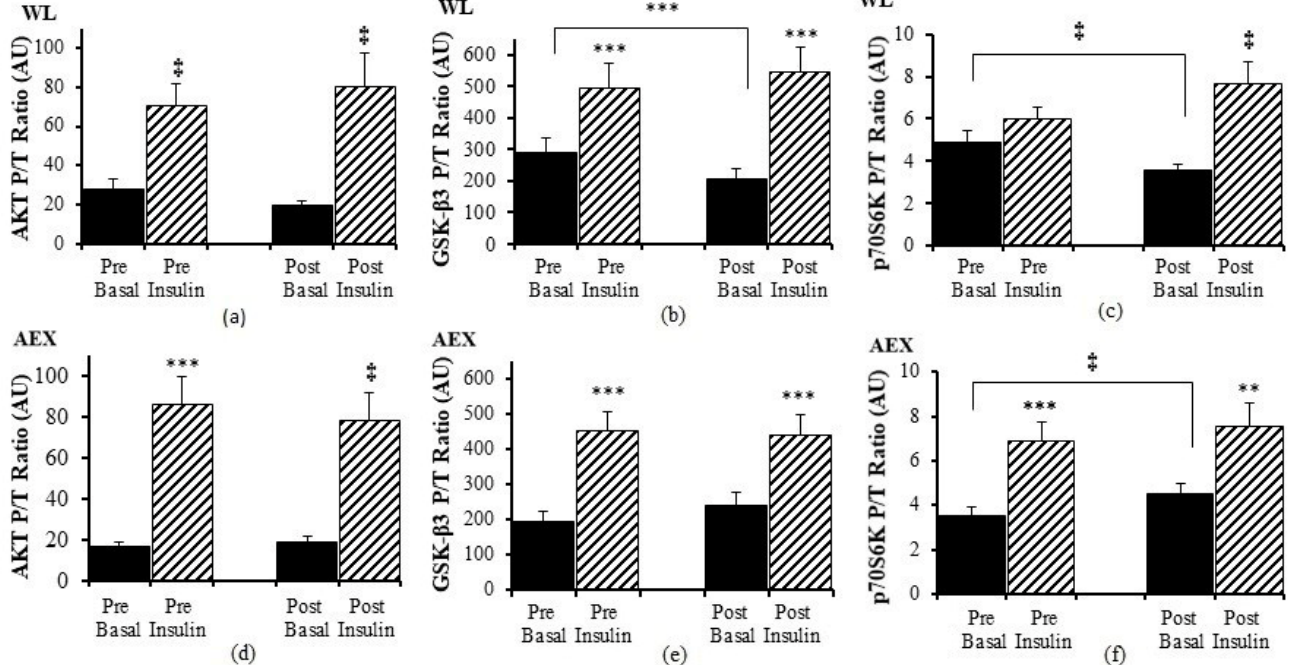
Figure 1. Skeletal muscle Akt, GSK-3 β and p70S6K phosphorylation, and total protein expression ratio during basal (solid) and insulin-stimulated (striped) pre and post WL ( a – c ) and AEX ( d – f ). Paired t -tests between pre basal vs. pre insulin, post basal vs. post insulin, and pre vs. post basal analyses within WL and within AEX were performed using the SPSS software version 27 (SPSS Inc., Chicago, IL, USA). ** p ≤ 0.01; *** p ≤ 0.001, ‡ p ≤ 0.005.